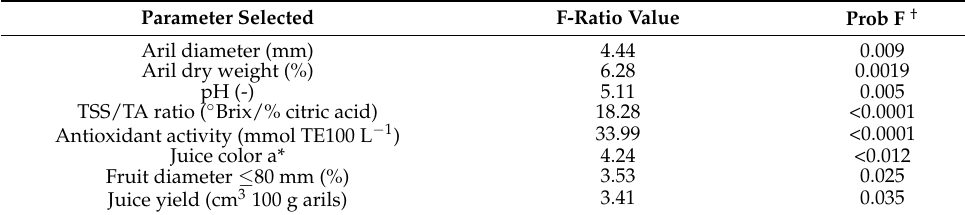
Table A2. Group of morpho-qualitative parameters selected by stepwise discriminant